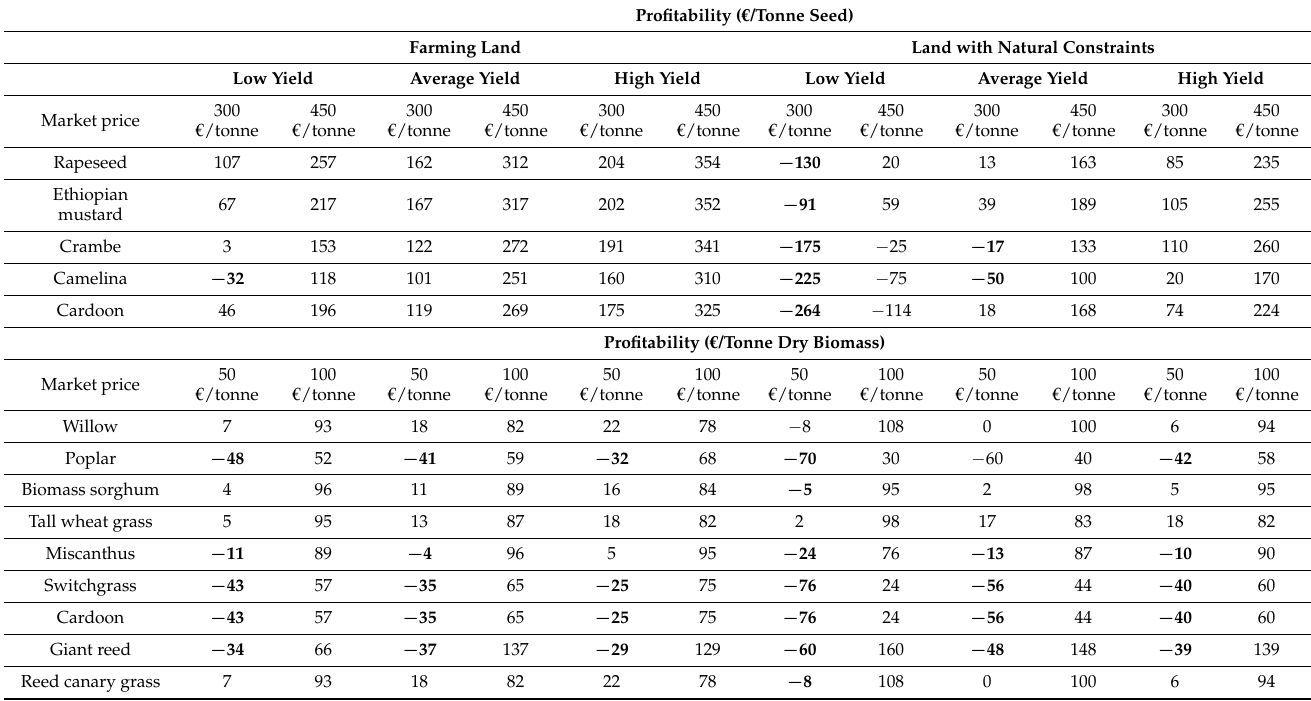
Figure 5. Lignocellulosic crops production cost ranges in € /tonne (with yield increases) in farming land (FL) and in land with natural constraints (LNC). Details in Table 4.